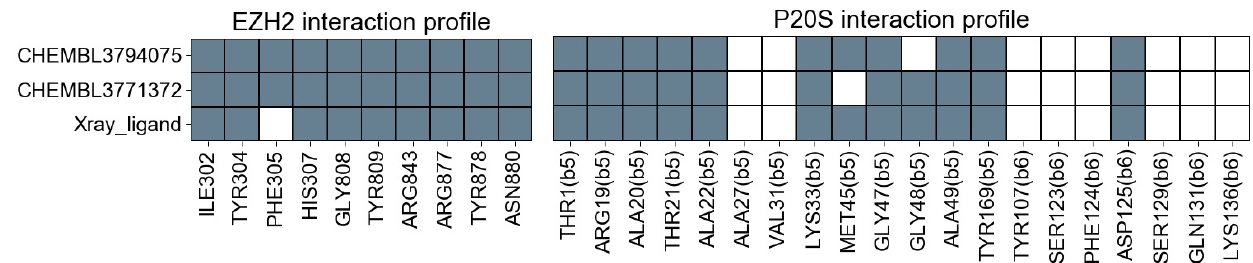
Figure 10. Plots of the enrichment curves calculated using the similarity of residue contacts between the ligands docked poses and the X-ray ligand. The curves are labeled in the plots as “TcN” where “Tc” refers to the Tanimoto coefficient which was the similarity function applied to the PLIFs profiles, and “N” is replaced by the amount of top N most frequent contacts observed in the ChEMBL datasets screened; ( A ) enrichment curves for the EZH2 inhibitors dataset, among which the yellow curve (using 10 residues) was selected to filter new predicted EZH2 inhibitors among known P20S inhibitors; and ( B ) enrichment curves for the P20S inhibitors dataset, among which the red curve (using 20 residues) was selected to filter new predicted P20S inhibitors among known EZH2 inhibitors.